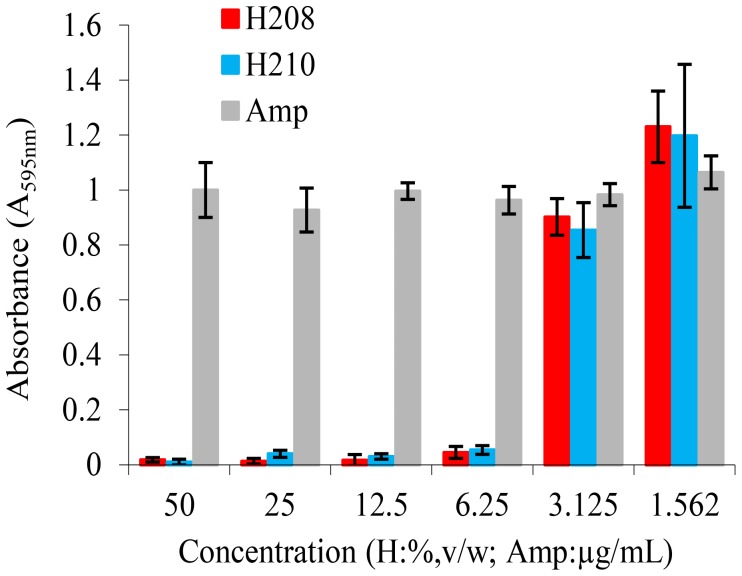
Susceptibility of ampicillin-resistant E. coli to honey and ampicillin.The bars represent the mean ± standard deviation (n = 9).